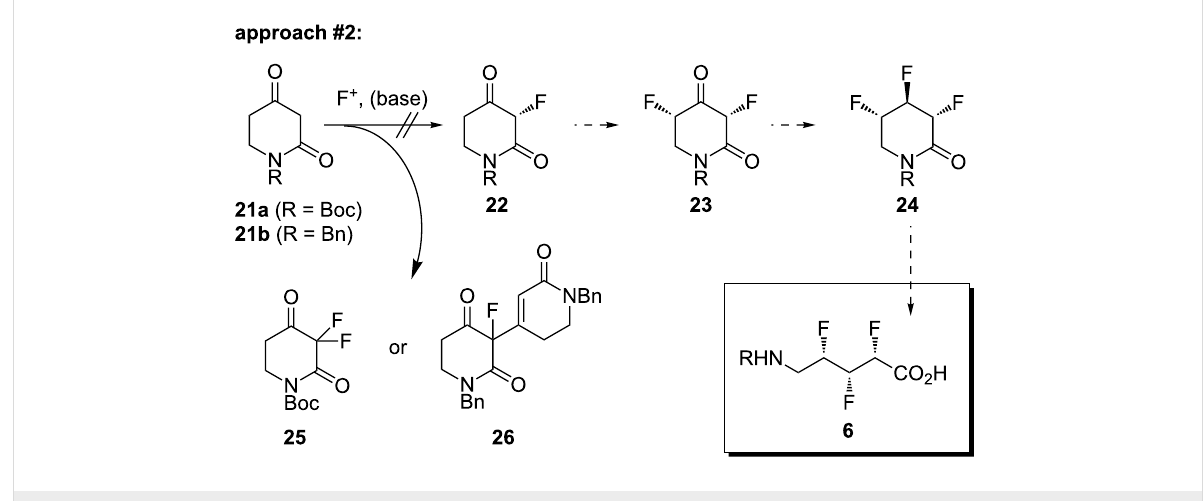
Scheme 2: The second synthetic approach.